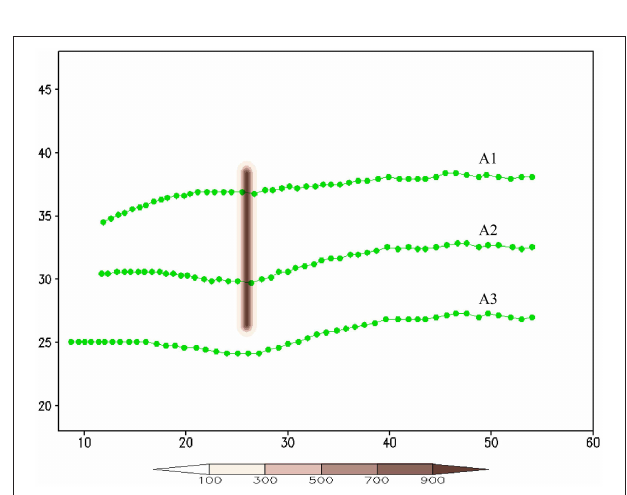
FIGURE 9 | The TC tracks for Tracks A1, A2, and A3. The units of the coordinates in the x and y directions are 100km.